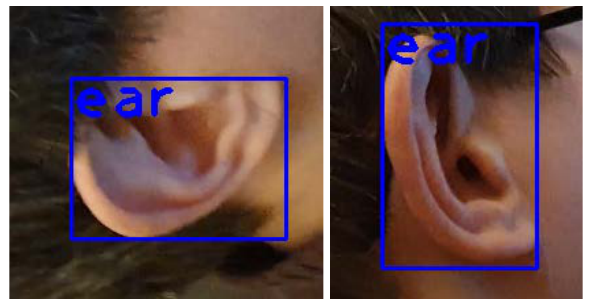
Figure 4. Two examples of how YOLO successfully found an ear from images.